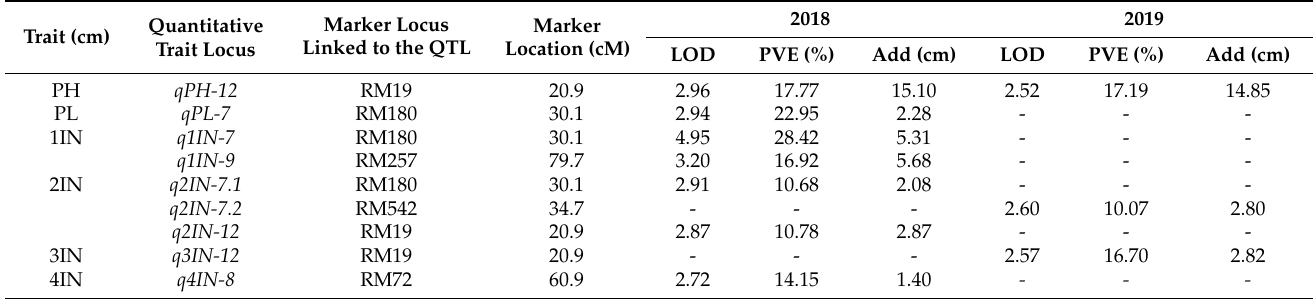
Table 4. QTLs for PH and its component traits detected in XC-CSSL population. Quantitative Trait (cm) Trait